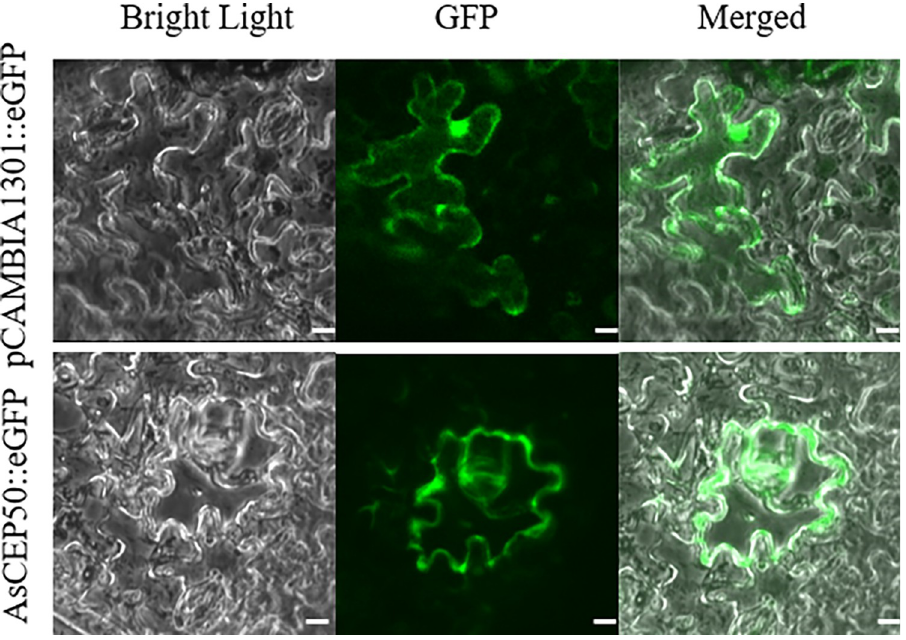
Fig 2. Subcellular localization of AsCEP5 0 proteins in N . benthamiana . The Agrobacterium strain EHA105 containing the pCAMBIA1301 vector as the control and the AsCEP50 gene were transiently expressed in the leaves of N . benthamiana . Bar=20 μ